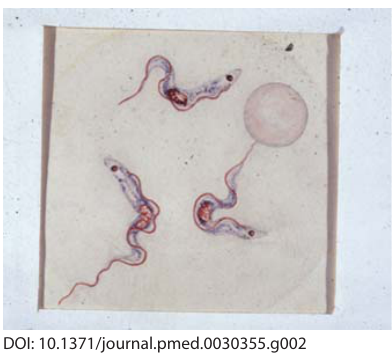
Figure 2. Watercolour of T. b. gambiense from the Original Description of the First Patient by J. E. Dutton, Gambia,